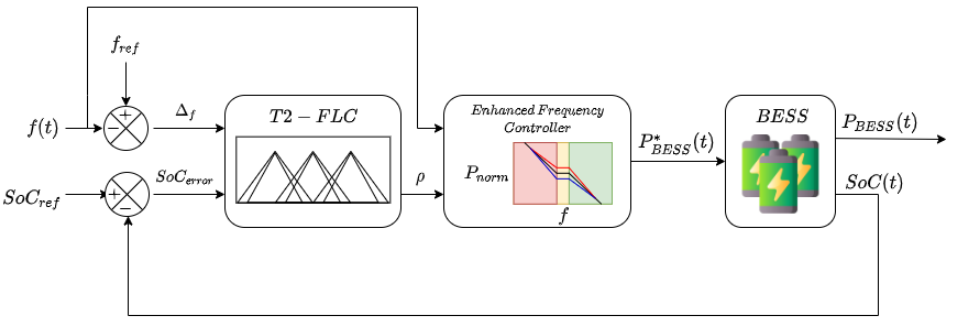
Figure 2. Proposed Type-2 FLC to enable EFR services from